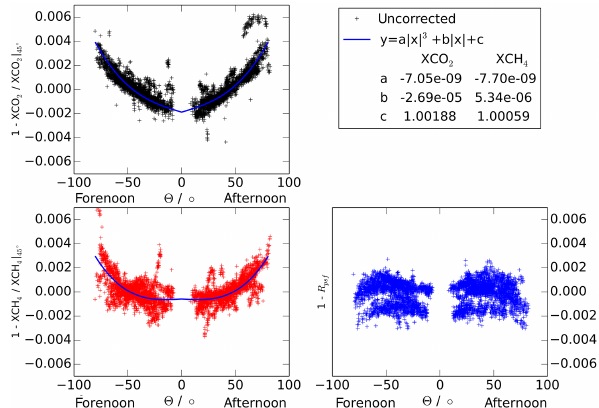
Figure 6. SZA dependency for CO 2 (upper left, referenced to XCO 2 at forenoon/afternoon SZA = 45 ◦ ), CH 4 (lower left, refer- enced to XCH 4 at forenoon/afternoon SZA = 45 ◦ ), and O 2 (lower right, surface pressure referenced O 2 retrieval R psf (see. Eq. (3)) as a function of SZA θ . Solid lines show the fitted SZA correction function.